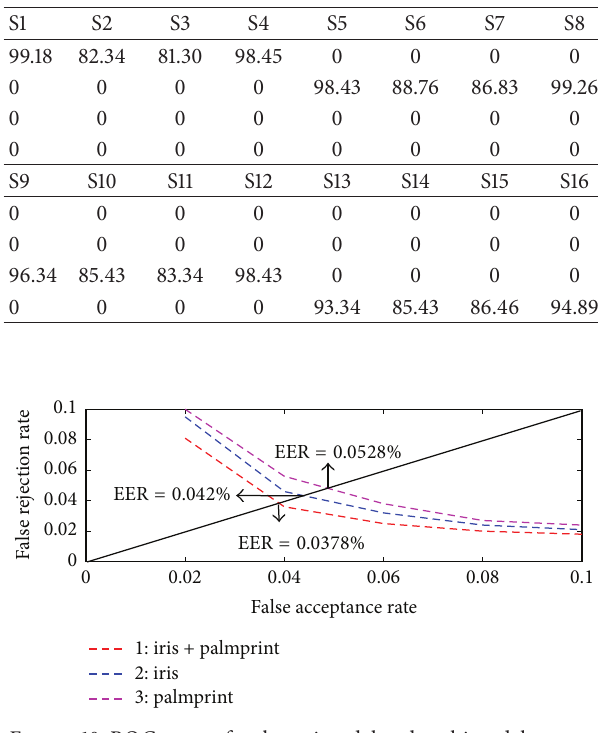
Figure 10: ROC curves for the unimodal and multimodal